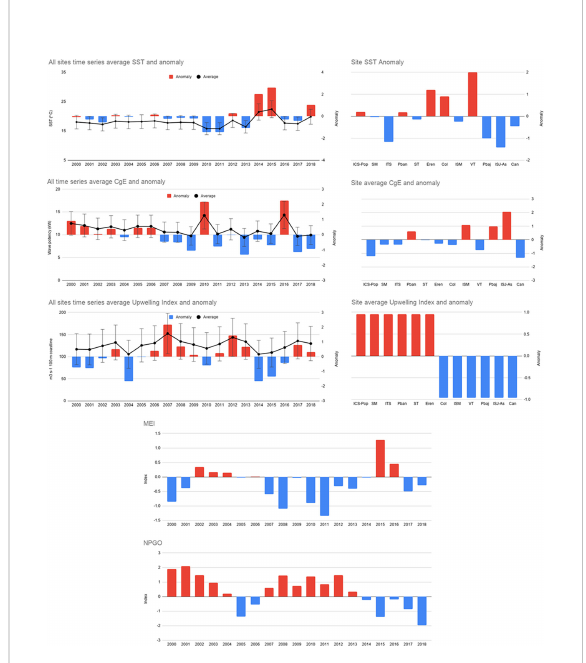
FIGURE 5 Local (Average SST, CgE), regional (Upwelling index), and oceanic (MEI, NPGO) variables values and anomalies from 2000 to 2018 and 19-year site anomaly.